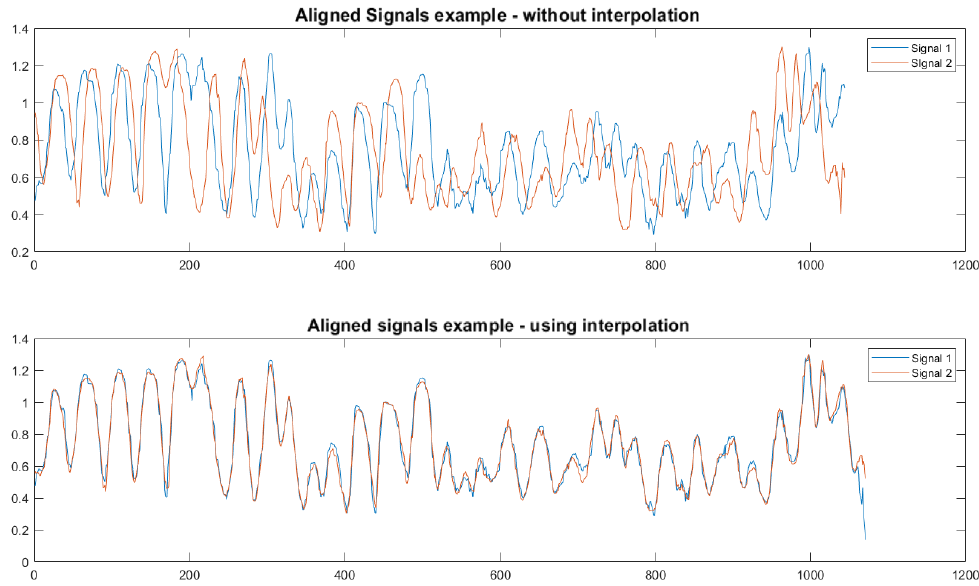
Figure 5. Examples of the aligned signals without ( top ) and with ( bottom ) re-sampling of the signals. Re-sampling allows overcoming the non-constant frame